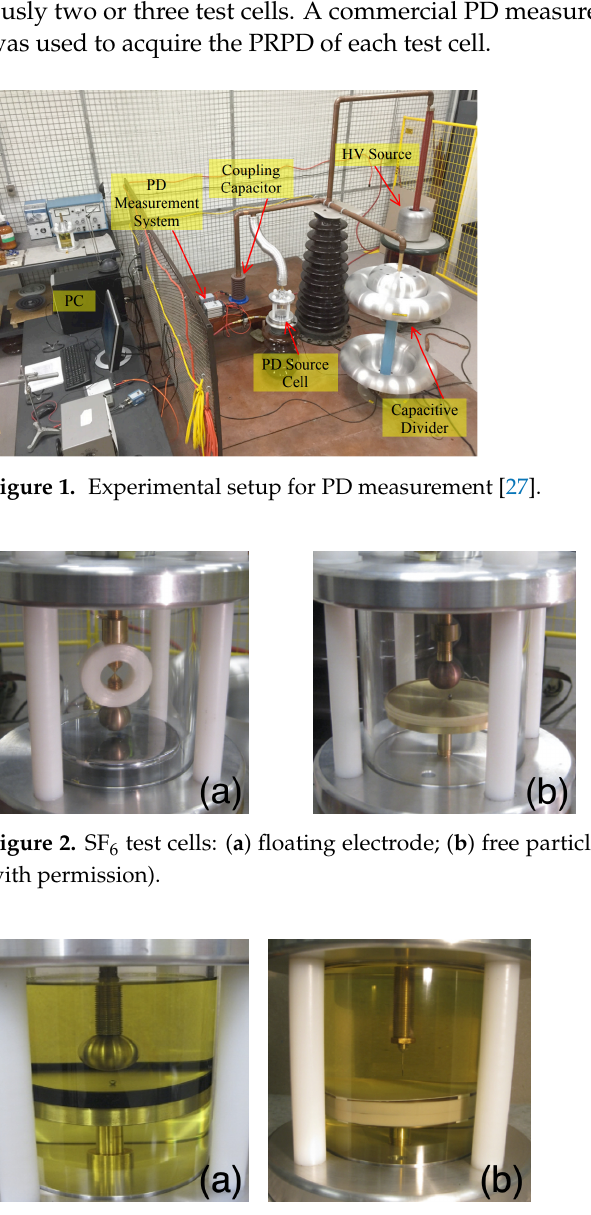
Figure 3. Oil test cells: ( a ) free particle; ( b ) point-plane electrode